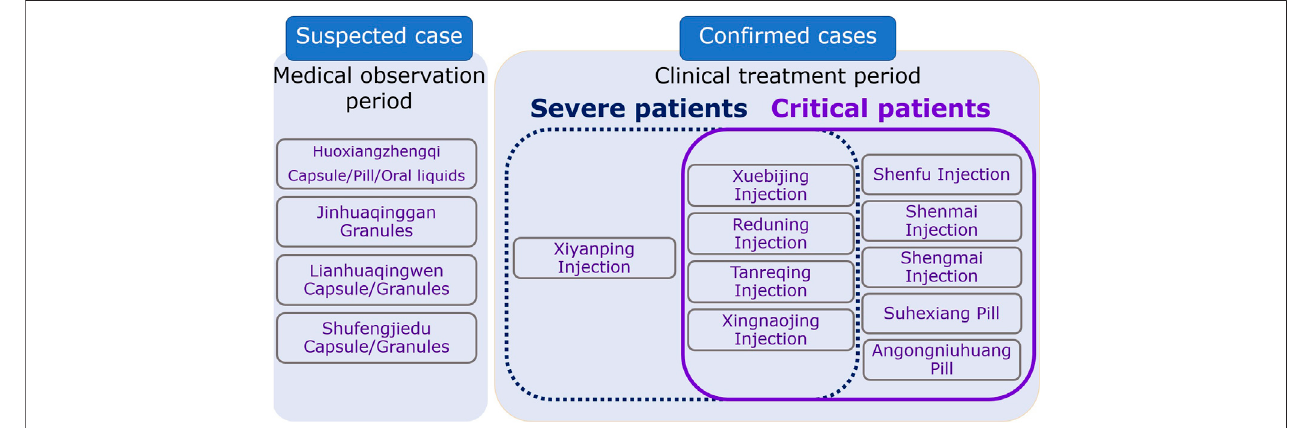
FIGURE 1 | Recommended CPMs and corresponding applicable patients with COVID-19.